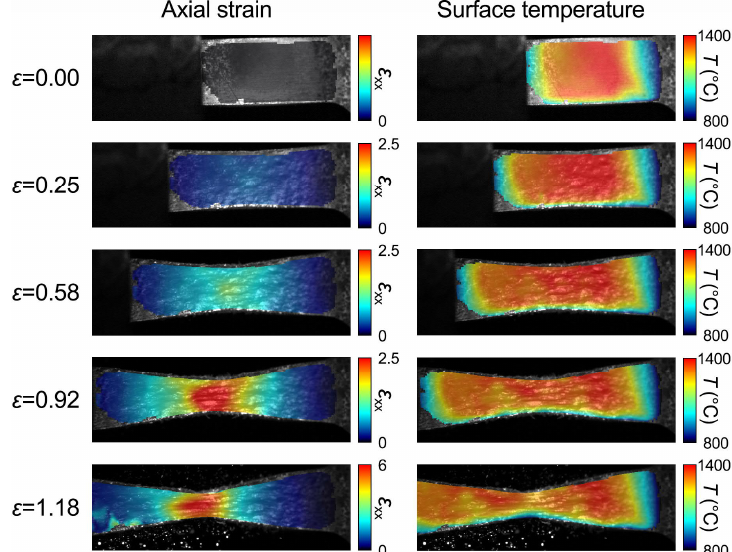
Fig. 2 : Full-field axial strain and temperature maps overlayed on the optical images of the specimen at different overall engineering strains of a commercially pure titanium specimen tested in tension at a strain rate of 1600 s − 1 and an initial temperature of approximately 1350